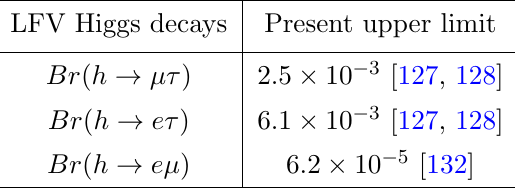
Table 2. Current experimental situation of LFV Higgs